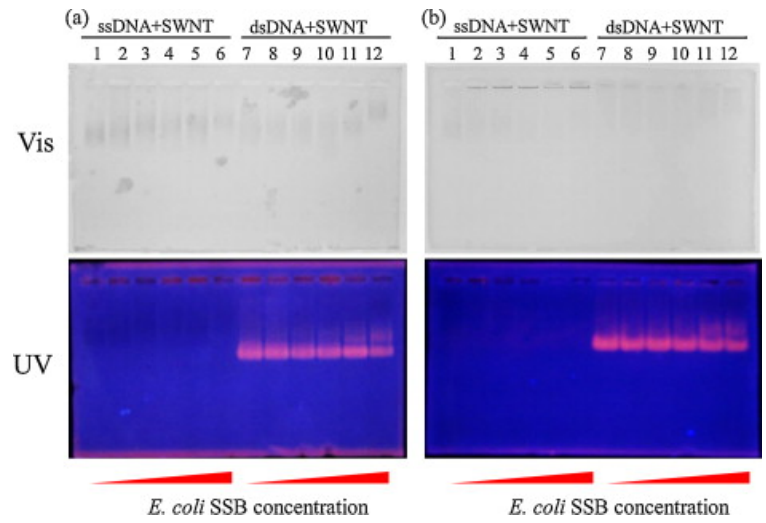
Figure 5. An example of agarose gel electrophoresis of DNA-SWNT hybrids with and without ssDNA-binding (SSB) proteins as performed by Nii et al. (Reprinted from reference [123] with